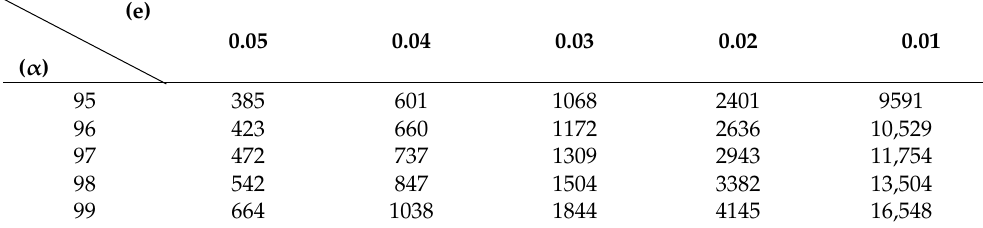
Table 1. Sample sizes for alternative confidence level ( α ) and margin error